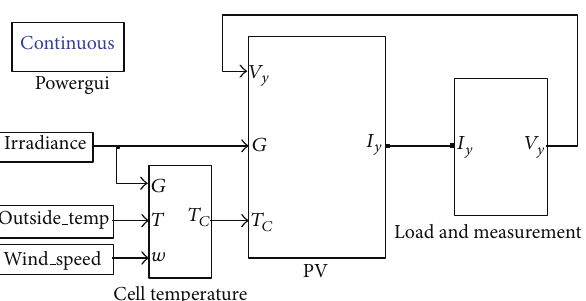
Figure 2: The Matlab/Simulink block diagram of PV